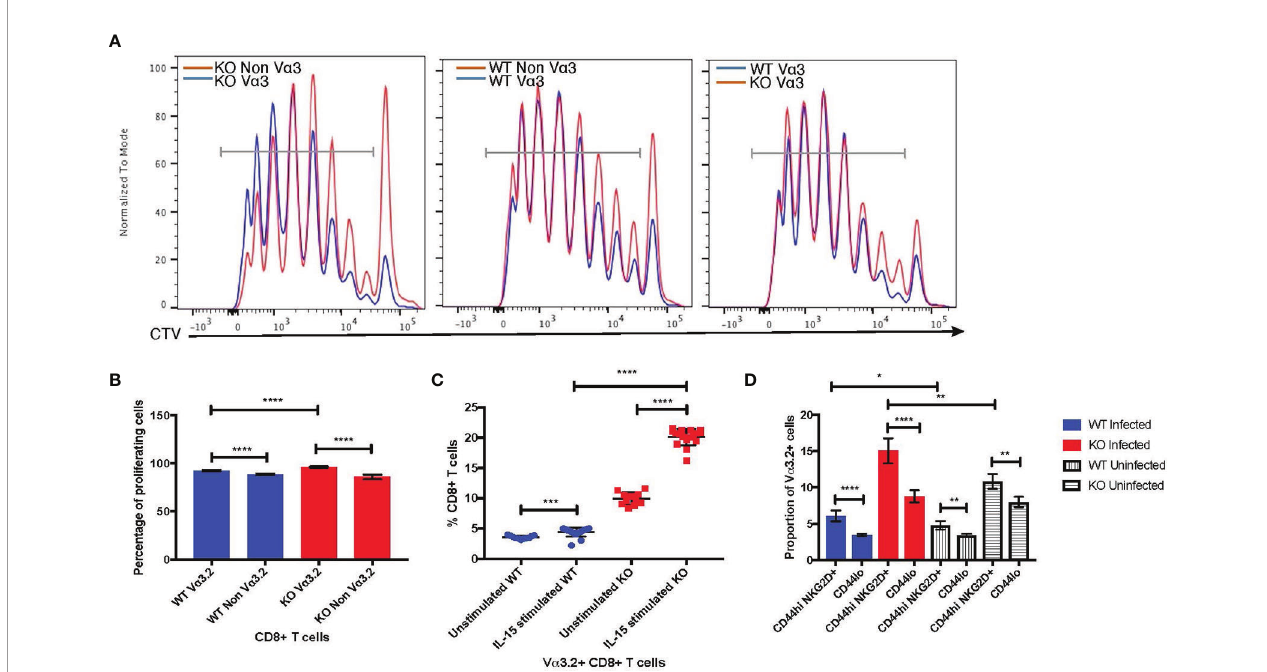
FIGURE 7 | Bystander potential of V a 3.2 + CD8 + T cells. (A) Proliferation of V a 3.2 + and V a 3.2- naïve CD8 + T cells from Themis – / – and Themis +/+ mice in response to IL-15 stimulation. (B) Histogram summary of the proliferative responses to IL-15 stimulation. (C) Proportion of V a 3.2 + and non-V a 3.2 + CD8 T cells upon IL-15 stimulation. (D) Proportions of V a 3.2 + T cells in the bystander (CD8 + Tetramer neg CD44 hi NKG2D + ) and control (CD8 + Tetramer neg CD44 lo ) population on day 4 of LM-OVA infection in uninfected and infected Themis – / – and Themis +/+ mice. Data are representative from three independent experiments with 3-4 biological replicates per genotype per experiment. ns not signi fi cant, *p < 0.05, **p < 0.01, ***p < 0.001, ****p < 0.0001 as determined by two-sided Student ’ s t-test. All error bars represent